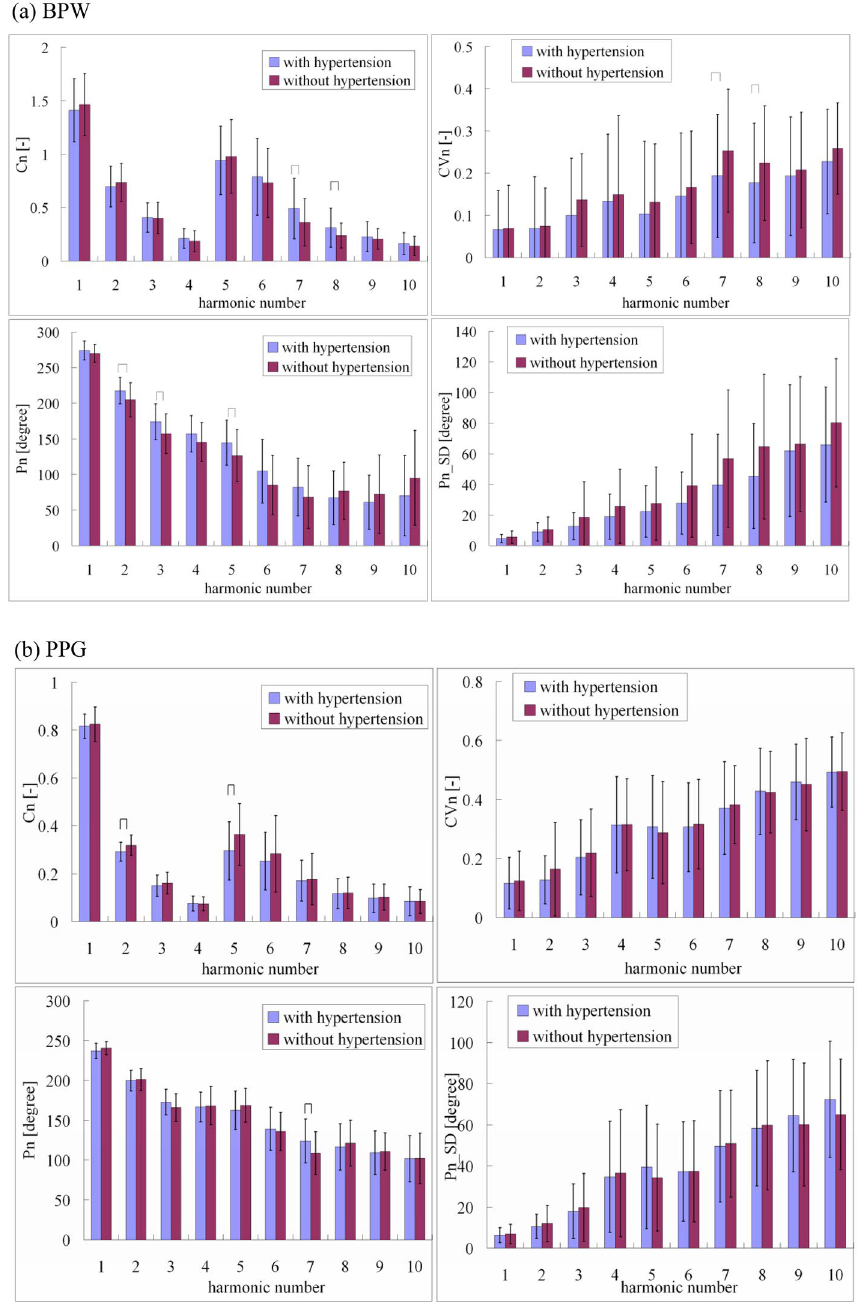
Figure 5. Comparisons of ( a ) BPW and ( b ) PPG harmonic indices between subjects with and without hypertension: C n , CV n , P n , and P n _ SD . Data are mean and standard-deviation values. C 5 – C 10 values have been multiplied by 5 to make the differences clearer. “ ⌢ ” indicates p < 0.05. In BPW indices, only C 7 , C 8 , CV 7 , CV 8 , P 2 , P 3 , and P 5 differed significantly between subjects with and without hypertension. In PPG indices, only C 2 , C 5 , and P 7 differed significantly between subjects with and without